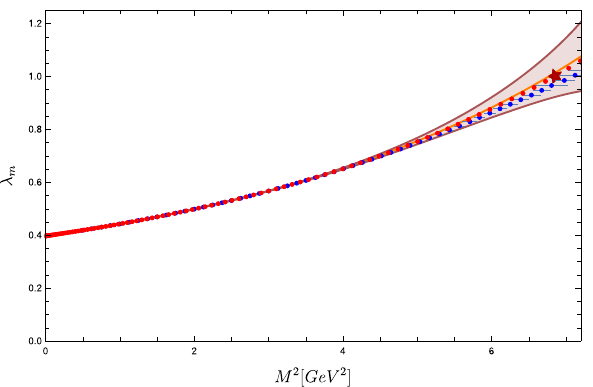
Fig. 9 Extrapolation exemplified with a meson of mass M = 2 . 62GeV.Thereddotsrepresenttheexactsolutionsfortheeigenvalues, the star the physical one. The orange line is the averaged extrapolation with errors indicated by the band. The horizontal error bars represent the errors for specific mass values. Below 2GeV, the agreement is so good that the points lie on top of each other